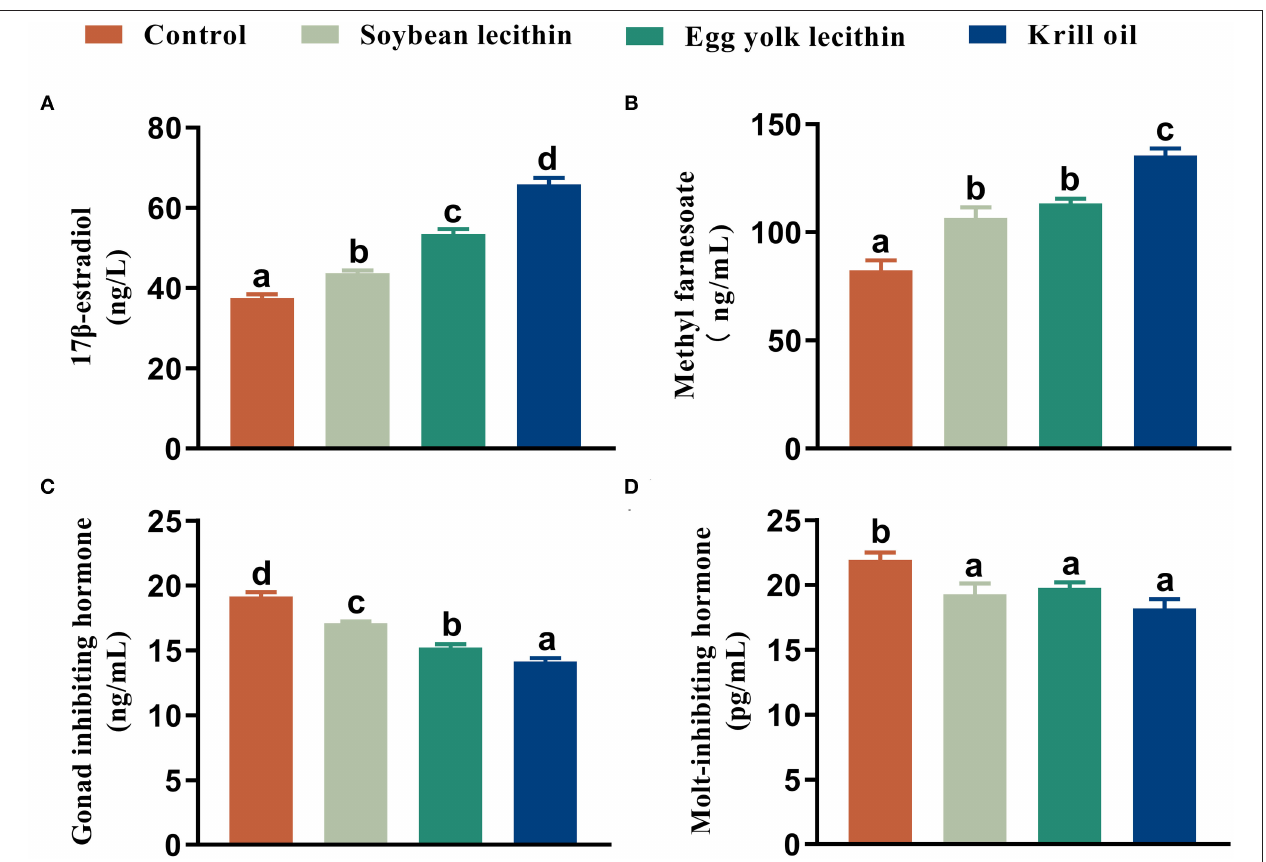
FIGURE 5 | Content of reproductive hormone secretion female L. vannamei fed with different experimental diets. (A) 17 β -estradiol content in serum. (B) Methyl farnesoate content in serum. (C) Gonad inhibiting hormone content in eyestalk. (D) Molt-inhibiting hormone content in eyestalk. The values are the mean ± standard errors ( n = 4). Bars with different superscripts are significantly different ( p < 0.05, single factor analysis of variance and Duncan’s